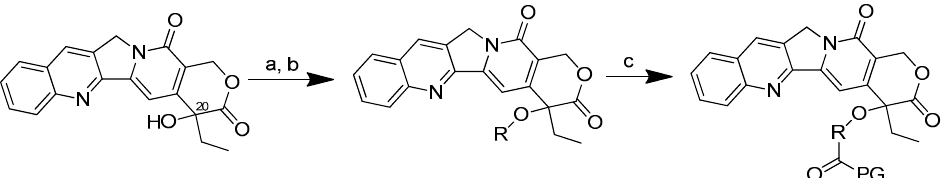
Figure 4. Poly-R-(L-glutamic acid)-L-glycine-camptothecin. Table 2. Effects of poly-R-(L-glutamic acid) conjugates of camptothecin on the in vivo growth of subcutaneous B-16 melanomas. TGD: tumour growth delays. ( 1 ) Poly-R-(L-glutamic acid)-camp- tothecin; ( 2 ) poly-R-(L-glutamic acid)-glycine-camptothecin; ( 3 ) poly-R-(L-glutamic acid)-alanine- camptothecin; ( 4 ) poly-R-(L-glutamic acid)-( β -alanine)-camptothecin; ( 5 ) poly-R-(L-glutamic acid)- (4-NH-butyryl)-camptothecin; ( 6 ) poly-R-(L-glutamic acid)-(2-O-acetyl)-camptothecin; ( 7 ) poly-R- (L-glutamic acid)-(4-O-butyryl)-camptothecin; ( 8 ) poly-R-(L-glutamic acid)-( γ -glu)-camptothecin. Compound Dose ( mg